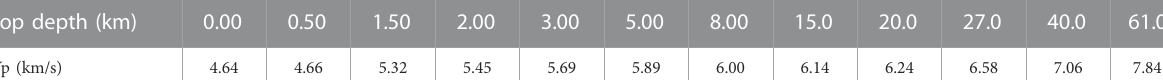
TABLE 2 Local 1-D velocity model for the study region.